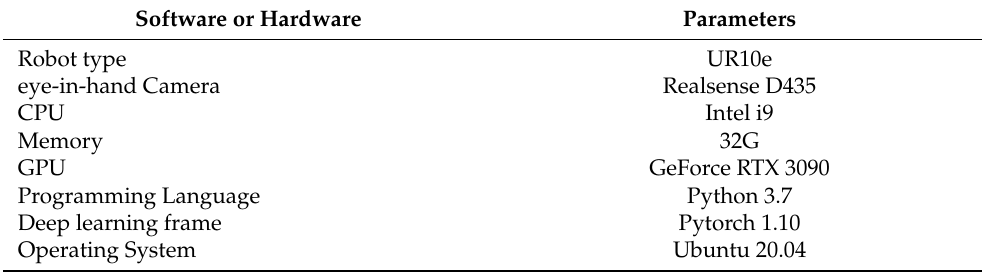
Table 4. Information about the components used in the experiment.